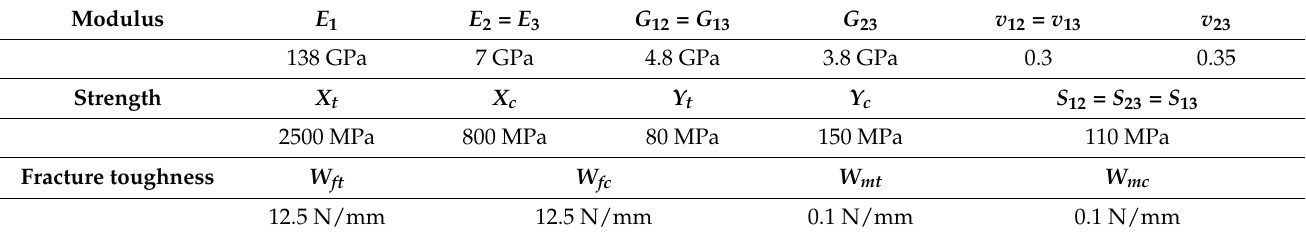
Table 1. Static material properties of single-layer plate at room temperature [7].